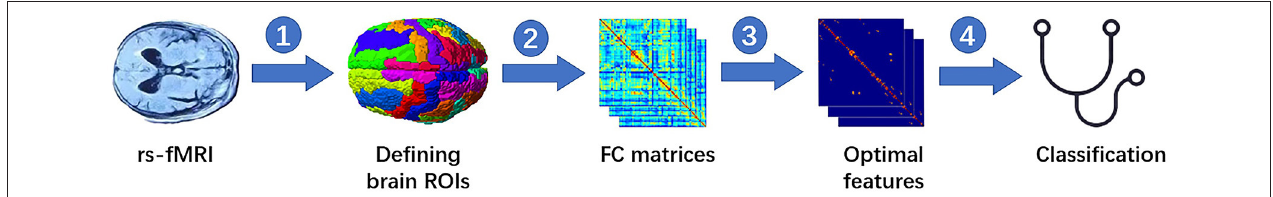
FIGURE 1 | Classification of flow chart with four main steps: (1) defining the ROIs from the rs-fMRI images or by using anatomical templates that have been defined, (2) extracting rs-fMRI time series based on the ROIs and calculating the FC matrices, (3) using feature selection method to define the optimal features from the FC matrices, and (4) training a classifier. ROIs, region of interests; rs-fMRI, resting-state functional MRI; FC, functional connectivity.